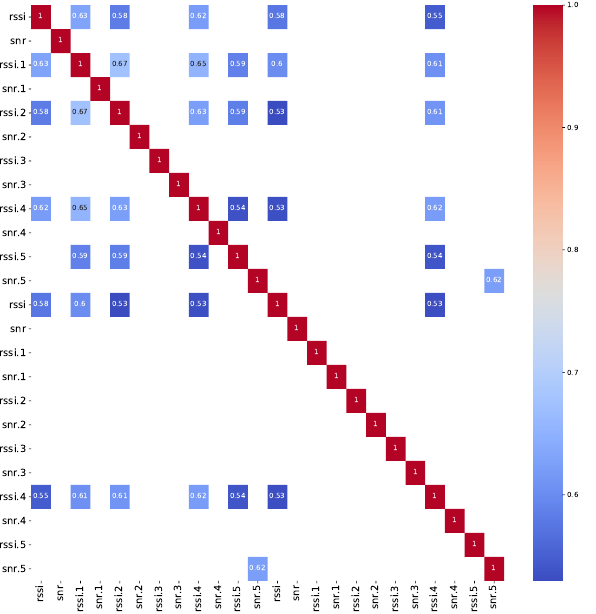
Figure 14. Data correlation for RSSI and SNR values for ROOM A507 and location points 9 and 11 for SF